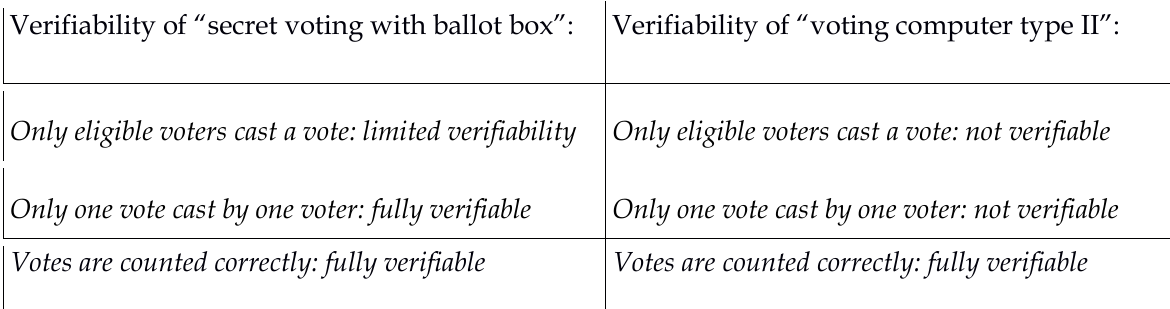
Table 1: Secret Ballot / Computer-Based Voting Verifiability Comparison Verifiability of “secret voting with ballot box”: Verifiability of “voting computer type